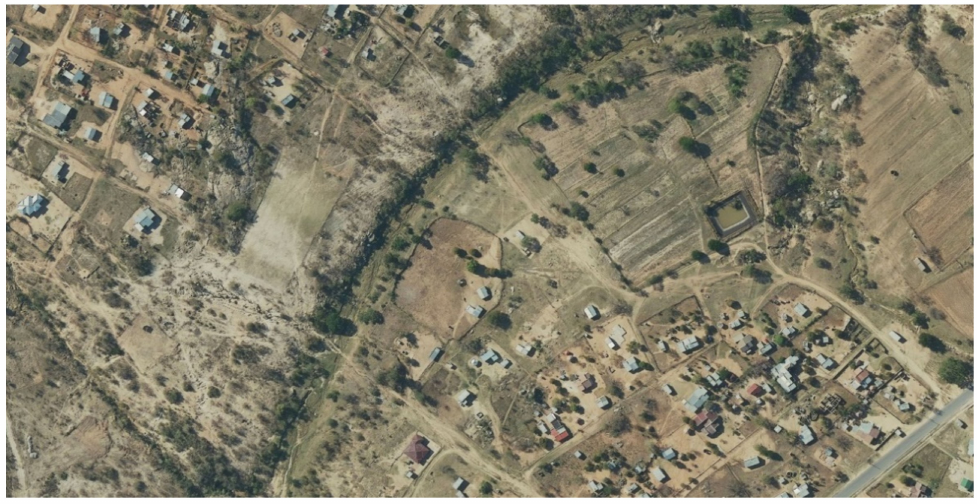
Figure 8. Extract from 2018 rectified imagery [12] (Ref: 2531 AD 16), showing an informal settlement in an area known as Luphisi, in Mpumalanga Province, at scale: 1:10,000